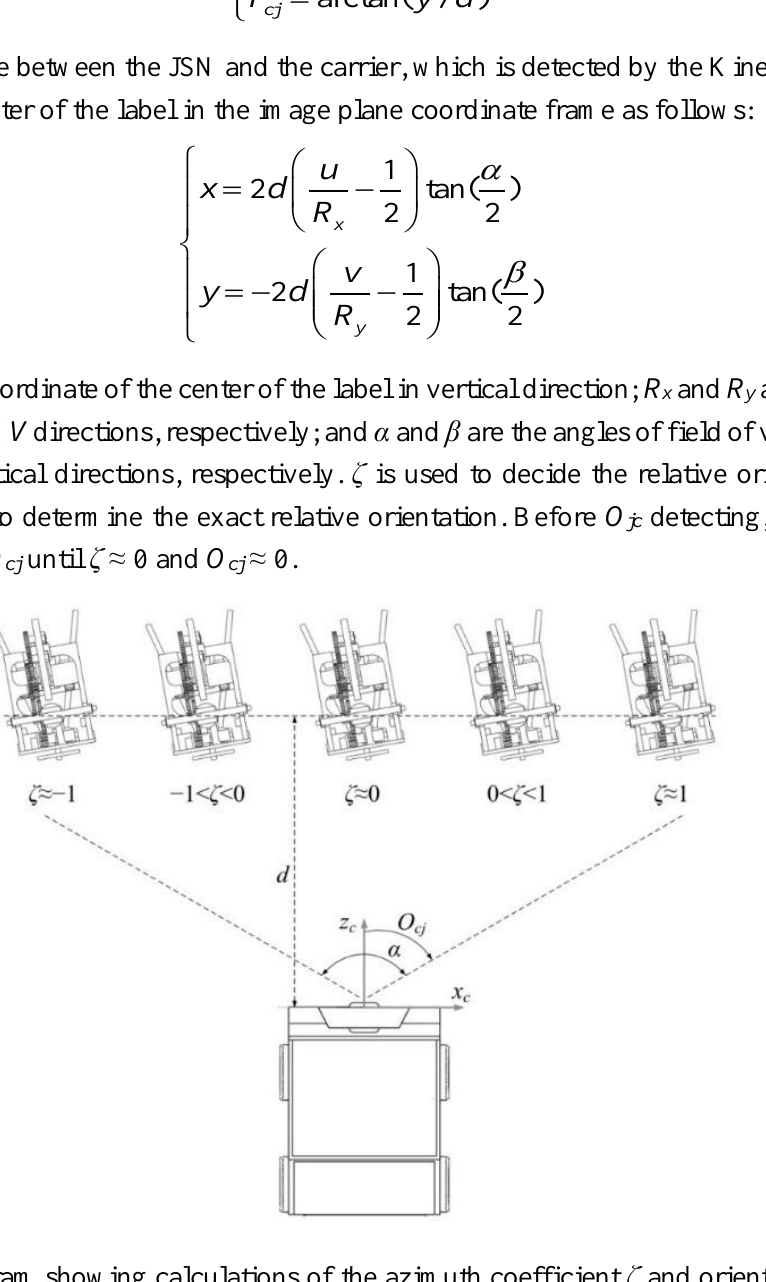
Figure 5. Diagram showing calculations of the azimuth coefficient ζ and orientation O cj of the carrier relative to the